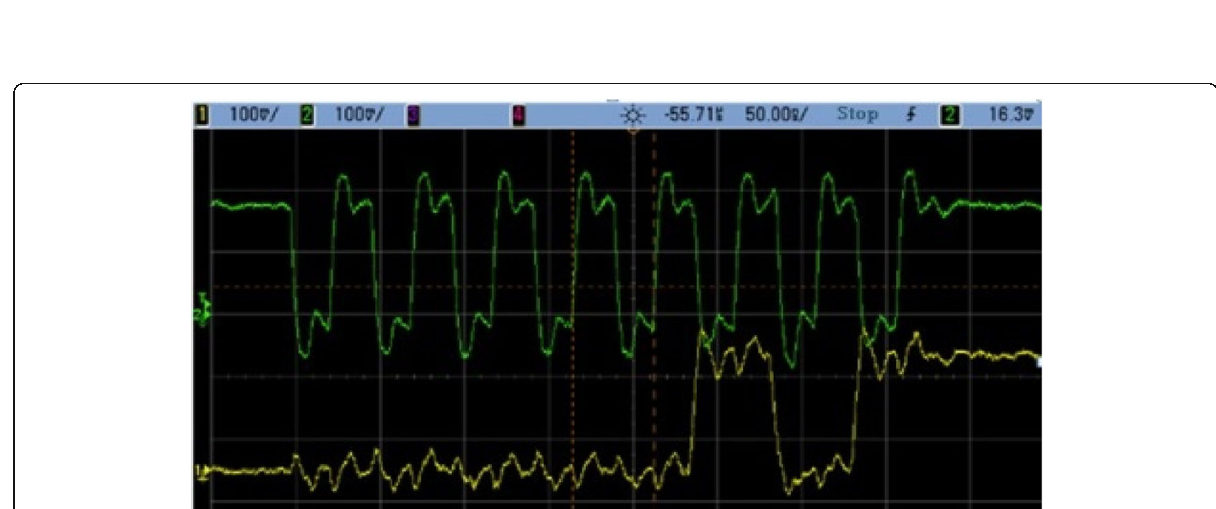
Fig. 37 The interrupt waveform of gyro sensors